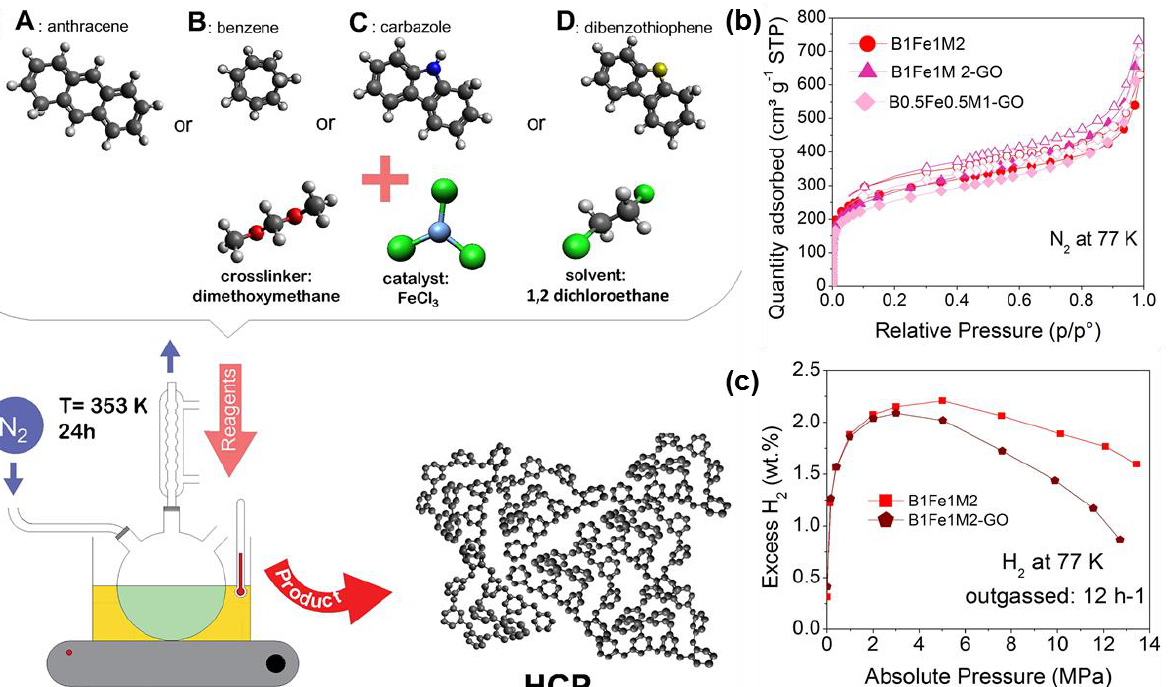
Figure 7. ( a ) Schematic illustration of the preparation process for hyper-crosslinked polymers (HCPs); the monomers used were (A) anthracene, (B) benzene, (C) carbazole, and (D) dibenzothio- phene. ( b ) Adsorption–desorption isotherms for N 2 at 77 K. ( c ) Hydrogen adsorption curves at 77 K and 14 MPa for COF (B1Fe1M2) and COF-GO composites (B1Fe1M2-GO) after the first 12 h of out- gassing. Reproduced from ref. [82] ; copyright (2022) with permission from Elsevier.